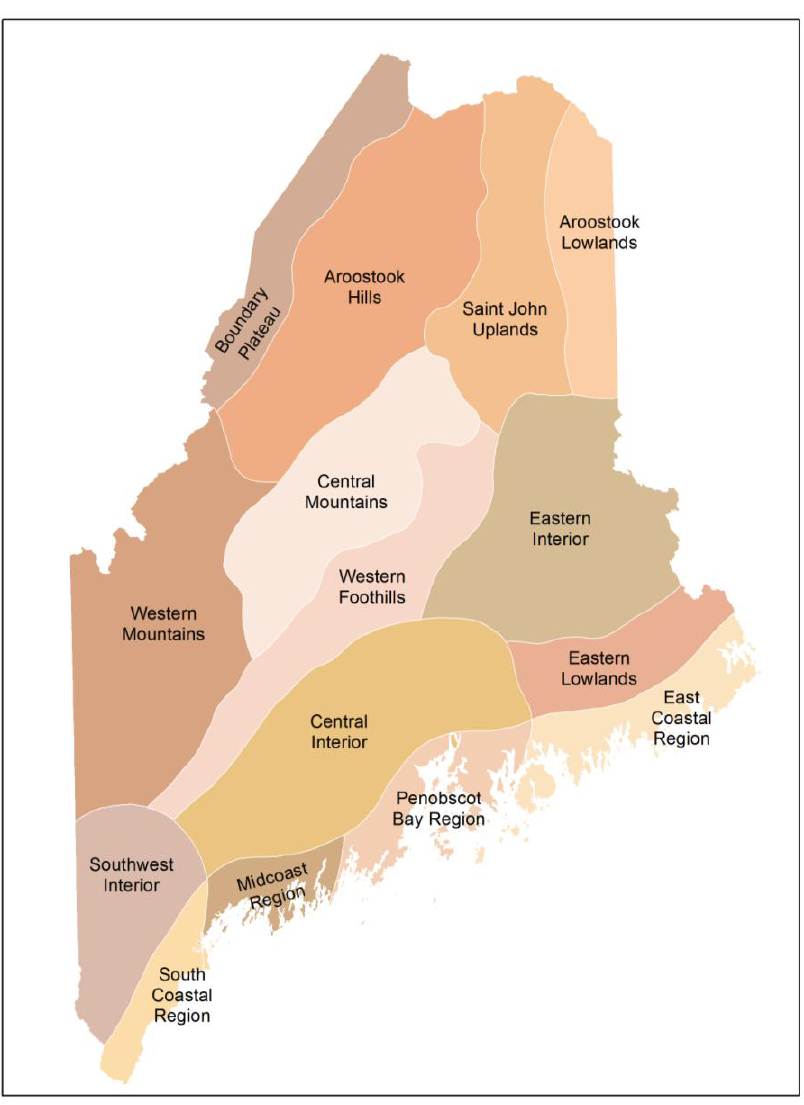
Figure 1. Map of Biophysical Regions of Maine, based on [22]. Map from the Maine Office of Geographic Information Systems